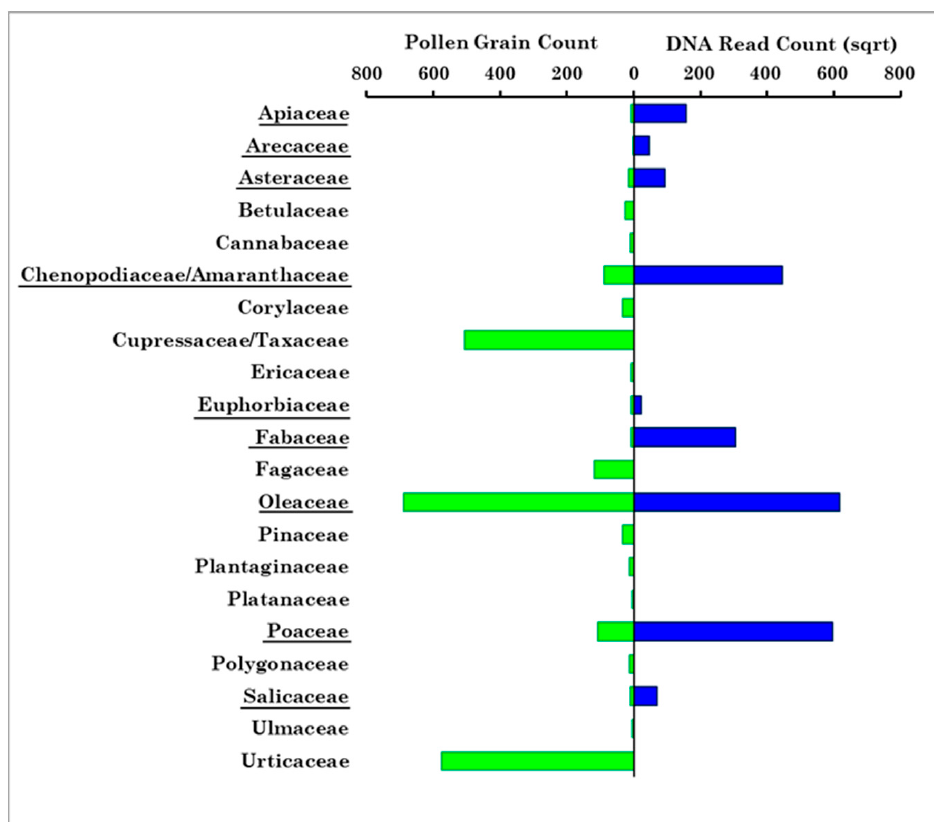
Figure 9. Comparison between the total number of each of the twenty-one family pollen grains counted by optical microscopy in Brindisi (Table S3) and the corresponding number of sequence reads of the nine shared pollen families detected in Lecce, which are underlined in the figure. The number of sequence reads has been square-root-transformed for visualisation purposes.